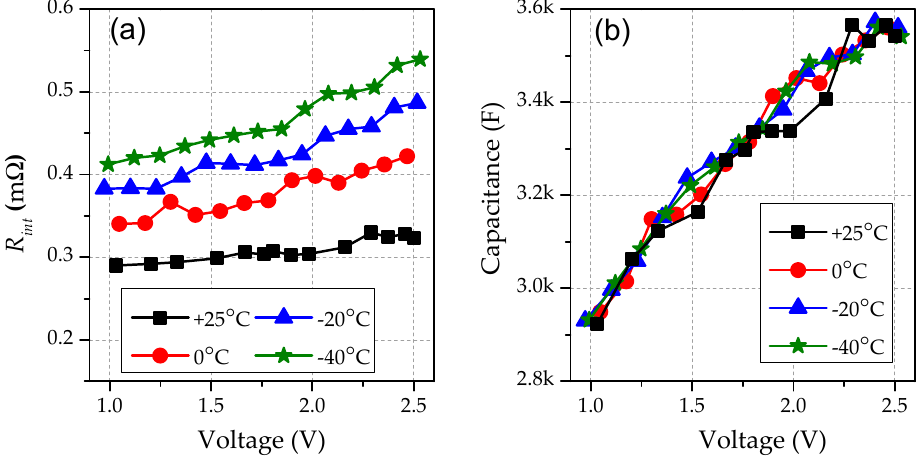
Figure 5. ( a ) Internal resistance and ( b ) capacitance measured at different temperatures (+25 °C, 0 °C, − 20 °C, and − 40 °C) as a function of voltage for the double-layer UC.